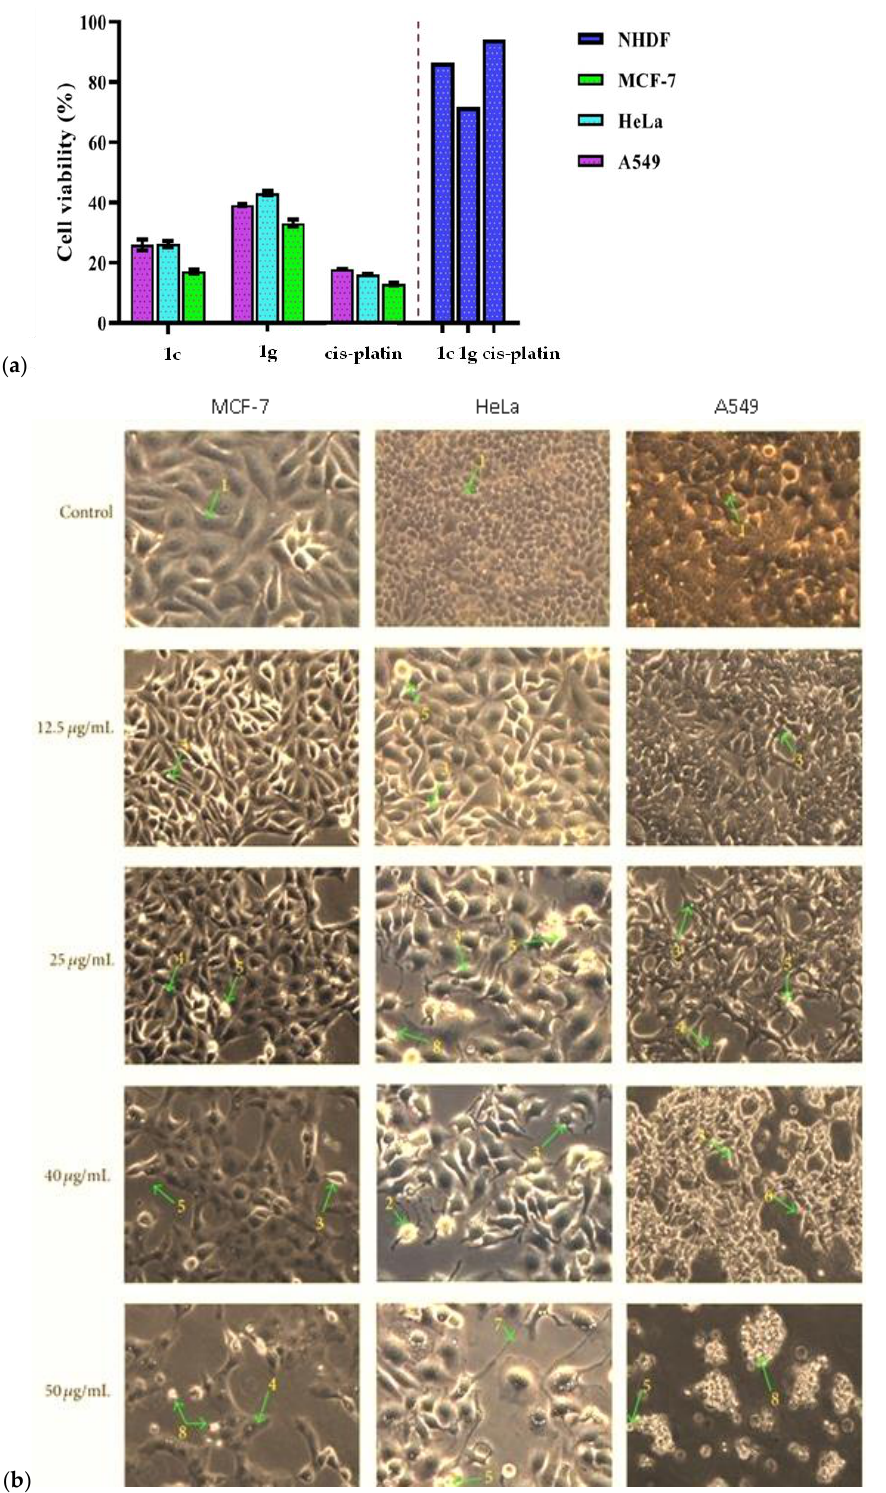
Figure 10. ( a ) In vitro anticancer activity of copper(II) complexes 1c and 1g against A549, HeLa, and MCF-7 cancer cell lines. ( b ) MTT-based antiproliferative photomicrographs of copper(II) complex 1c on MCF7 HeLa and A549 cancer cell lines after 24 h incubation under a phase contrast microscope. Arrows indicate (1) control cell, (2) condensed nuclei, (3) cell shrinkage, (4) membrane blebbing, (5) apoptotic bodies, (6) bubbling, and (7) echinoid spikes. Table 12. In vitro anticancer activity of metal(II) complexes 1c and 1g against A549, HeLa, and MCF- 7 cancer lines.